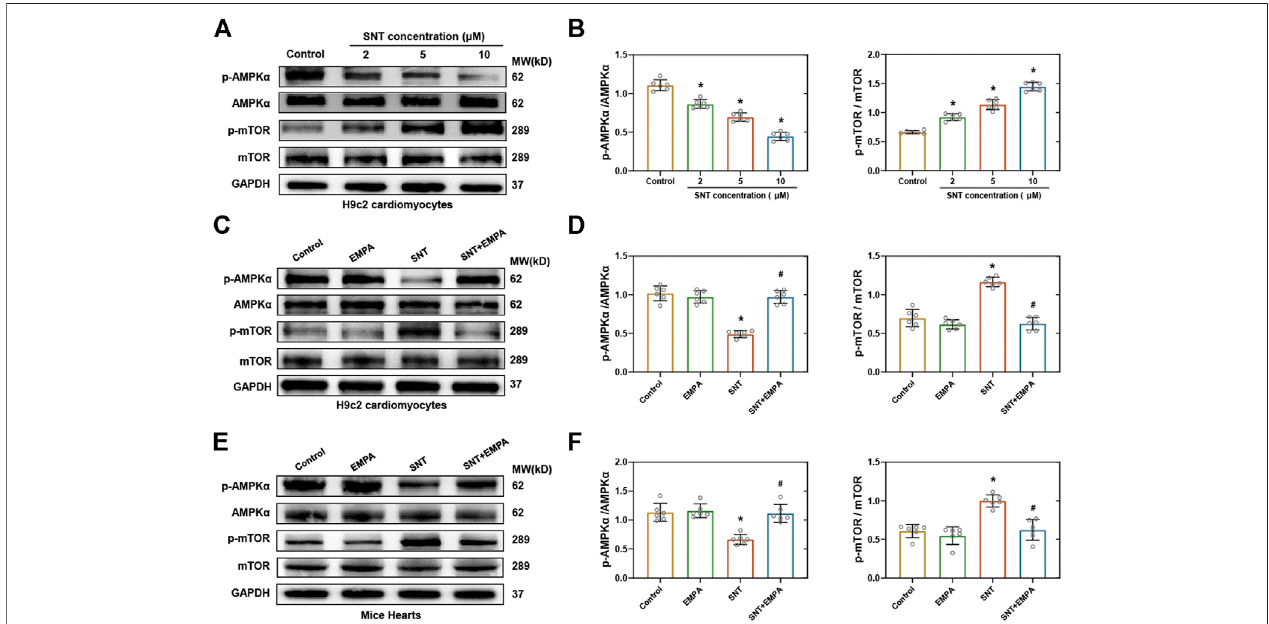
FIGURE 6 | EMPA restored SNT-induced dysfunction of the AMPK – mTOR signaling pathway both in vitro and in vivo . (A) Western blots of the AMPK – mTOR pathway in H9c2 cardiomyocytes treated with different concentrations of SNT. (B) Protein-level quanti fi cations of phosphorylated AMPK to total AMPK and phosphorylatedmTORtototalmTORratios, n (cid:1) 6pergroup. (C) WesternblotsoftheAMPK – mTORpathwayinH9c2cardiomyocytestreatedbyvehicle,EMPA,SNT,or SNT plus EMPA. (D) Protein-level quanti fi cations of phosphorylated AMPK to total AMPK and phosphorylated mTOR to total mTOR ratios, n (cid:1) 6 per group. (E) WesternblotsoftheAMPK – mTORpathwayinmiceheartstreatedbyvehicle,EMPA,SNT,orSNTplusEMPA. (F) Protein-levelquanti fi cationsofphosphorylatedAMPK to total AMPK and phosphorylated mTOR to total mTOR ratios, n (cid:1) 6 per group. * p < 0.05 vs. control, # p < 0.05 vs. SNT.